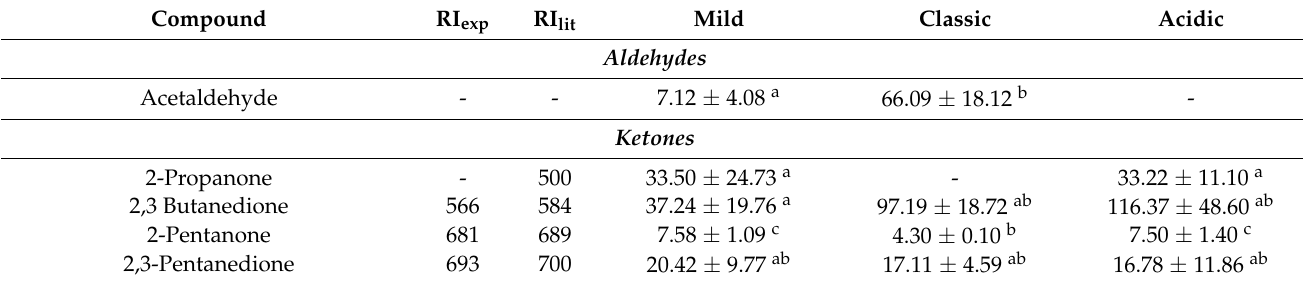
Table 3. Volatile compounds of goat dessert yogurts (mg kg − 1 ), prepared with different cultures, without the addition of Lactobacillus acidophilus